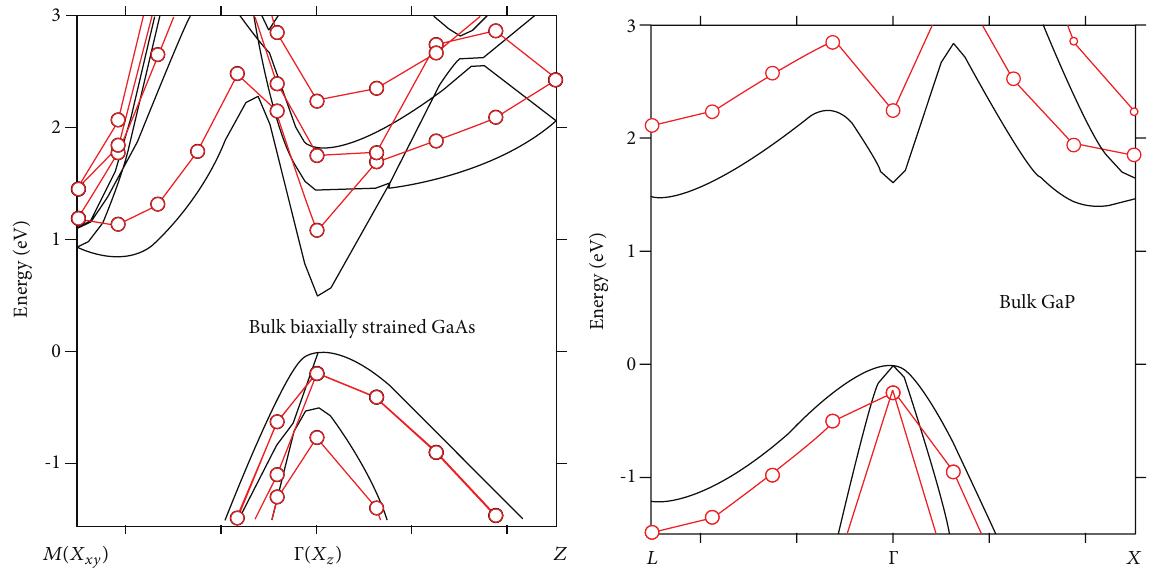
Figure 10: Electronic band diagrams of biaxially strained GaAs/GaP(001) and unstrained GaP bulk at LDA (dark lines) and LDA + G 0 W 0 (red lines with circles)